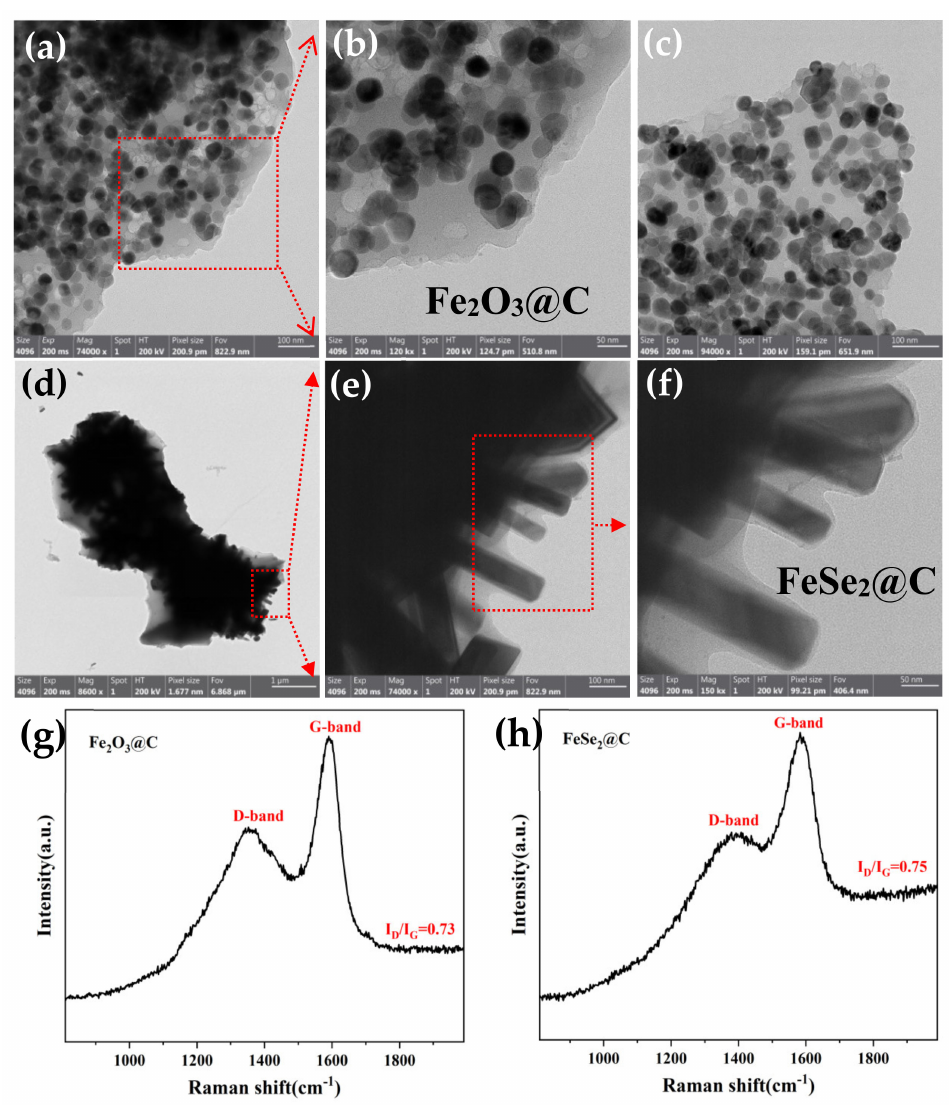
Figure 6. TEM images of Fe 2 O 3 @C ( a – c ) and FeSe 2 @C ( d – f ); Raman spectra of Fe 2 O 3 @C ( g ) and FeSe 2 @C ( h